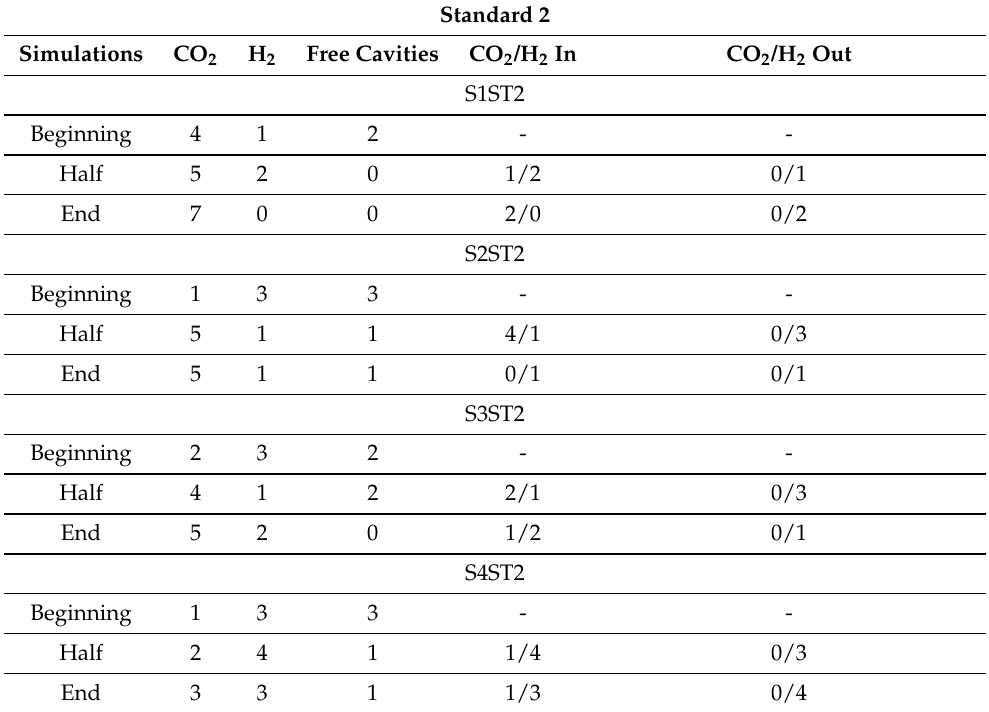
Table 5. Simulations for the ST2 runs (300 K and 1